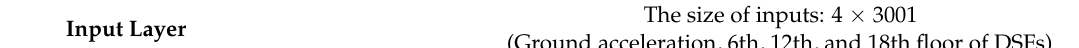
Table 8. Summary of each hidden layer in